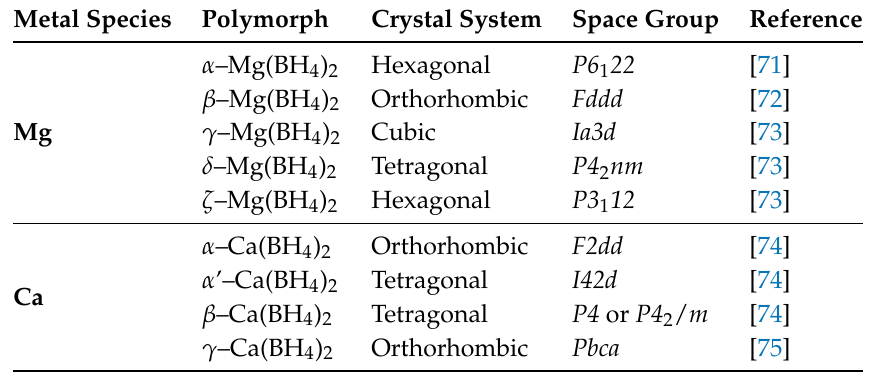
Table 3. Known experimental structures of the common alkaline earth borohydrides M(BH 4 ) 2 (M = Mg, Ca) [32]. Metal